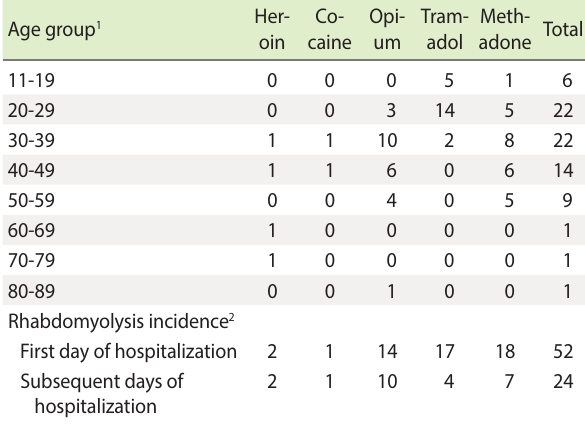
Table 2. Number of hospitalized patients with rhabdomyolysis in the intensive care unit (ICU) according to type of drug and age group in 2014